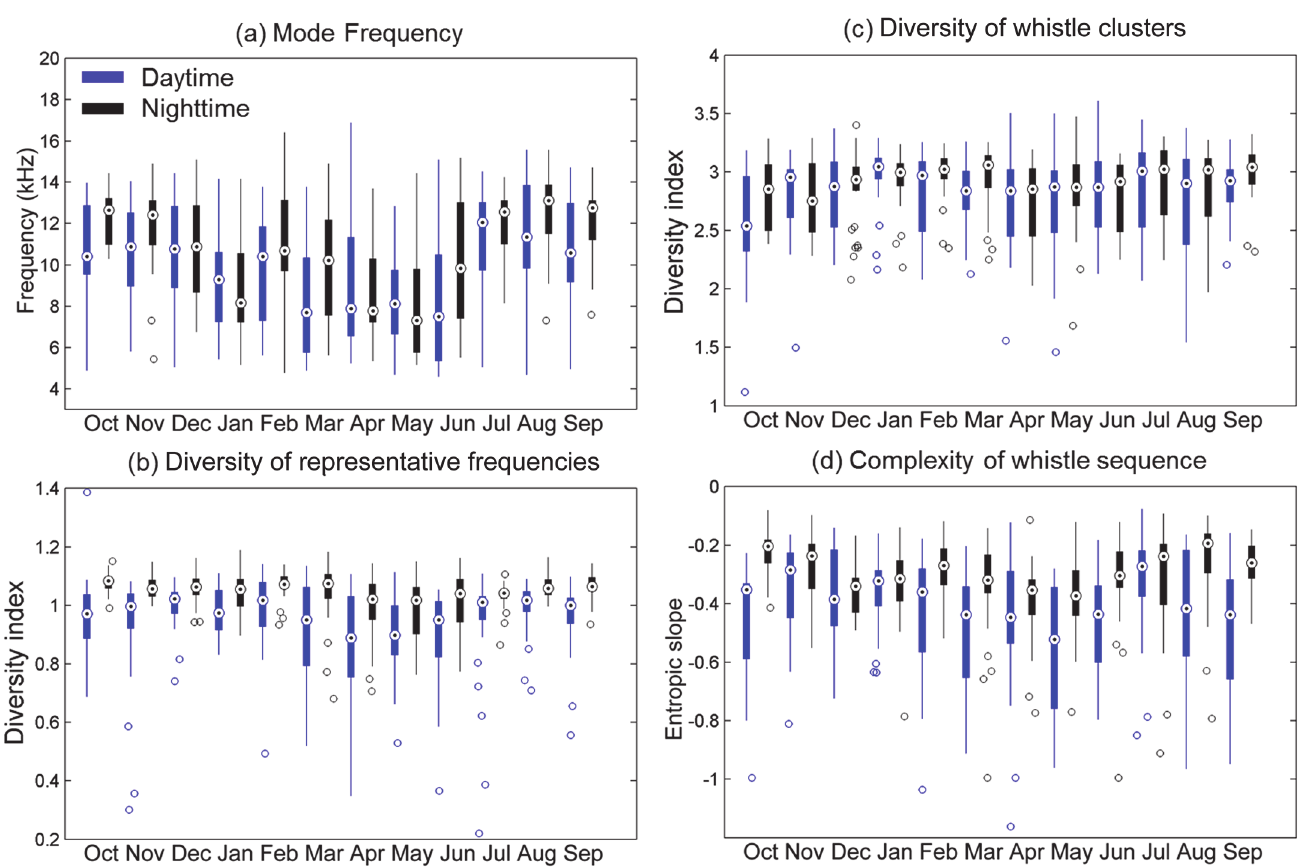
Fig 4. Seasonal and diurnal variation of whistle usage in mode frequency (a), diversity of representative frequencies (b), diversity of whistle clusters (c), and complexity of whistle sequence (d). The box plot shows the median (center point), interquartile range (box), minimum to maximum (error bar), and outliers (empty